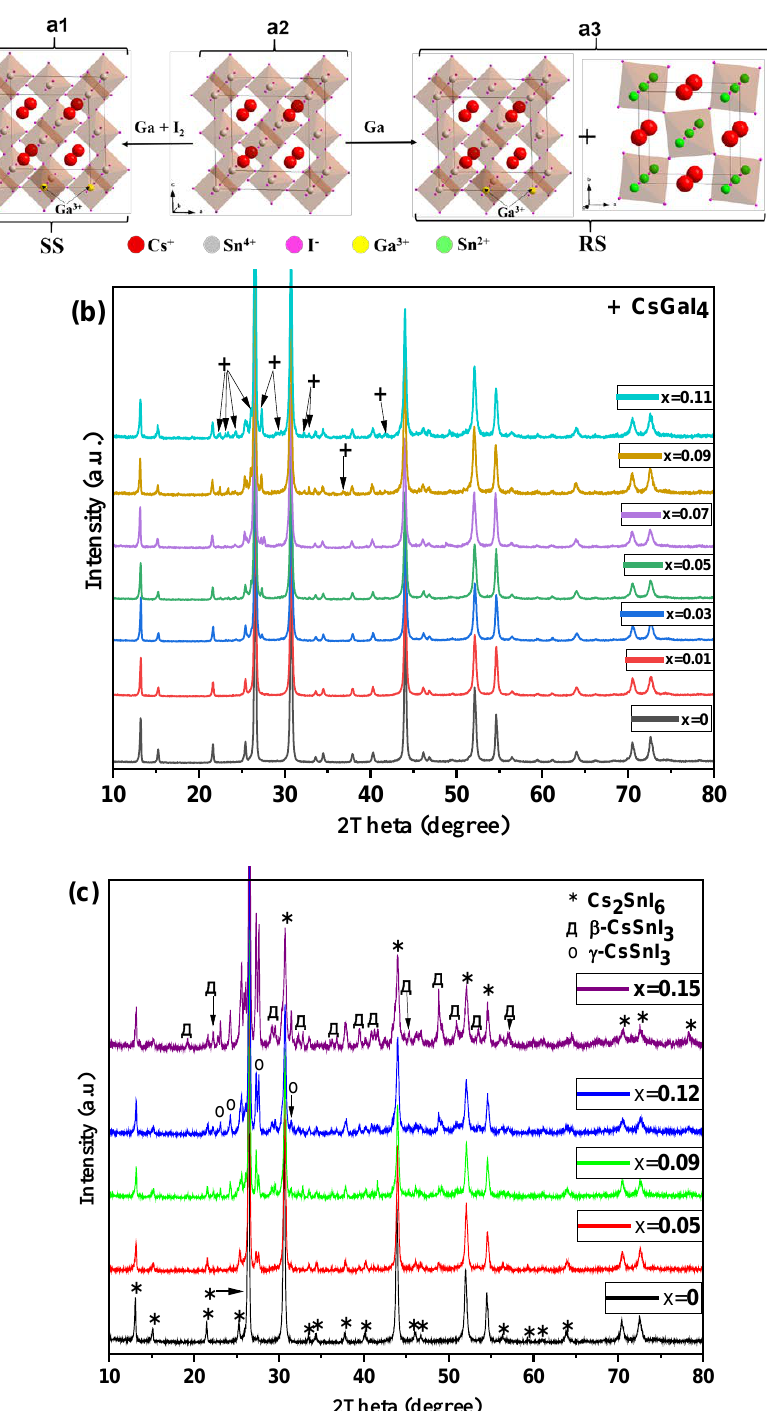
Figure 1. ( a1 ) Possible positions of heteroatoms (Ga 3+ ) in Cs 2 SnI 6 perovskite lattice; ( a2 ) Cs 2 SnI 6 unit cell; ( a3 ) Cs 2 SnI 6 reduction result. XRD data for ( b ) Cs 2 SnI 6 -based solid solutions and ( c ) the samples obtained by reduction with the melt of metallic gallium (x = 0–0.15). In diffractograms of SS samples, impurity-phase CsGaI 4 —reflections are marked with + symbols—and all unmarked reflections belong to Cs 2 SnI 6 . In diffractograms of RS series, β -CsSnI 3 peaks are marked with ⊗ -symbols, γ -CsSnI 3 peaks are marked with ο -symbols, and Cs 2 SnI 6 peaks with the symbol *. According to Figure 1b, the XRD patterns of two samples related to the SS series (namely, x = 0.01 and 0.03) and one related to the pristine Cs 2 SnI 6 (where x = 0) can be regarded as single phase. Contrastingly, the XRD patterns of the RS series (Figure 1c) distinctly show the presence of the β -CsSnI 3 secondary phase. The most intensive dif- fraction peaks are associated with reflections of Cs 2 SnI 6 (PDF2 file #73-330), while the weaker group of peaks is associated with reflections of γ -CsSnI 3 (PDF2 file #71-1898). The intensities and number of CsSnI 3 -characteristic reflections increase with the percentage of gallium in the samples before the heat treatment (0 → 0.15). Meanwhile, diffractograms do not show reflections of any iodogallates such as CsGaI 4 and CsGa 2 I 7 (Figure 1c). It is remarkable that for the samples with the substitution rate x of 0.09–0.15, the presence of B- β -CsSnI 3 (PDF2 file #80- 2138) was observed. This β -phase is stable ther- modynamically at higher temperatures of 78–152 °C but is present in the RS samples to- gether with low-temperature B- γ -CsSnI 3 . Table 1 shows the unit-cell parameters for the perovskite-related phase of Cs 2 SnI 6 , which were determined using the Le Bail method. The estimated unit-cell parameter a for the undoped Cs 2 SnI 6 perovskite phase was found to be 11.6416 (8) Å, which is close to recently reported data (11.630 (10) Å, according to the PDF2 file 73-330). The evolution of the unit-cell parameter with increasing dopant content for the SS samples demonstrated a slight increase of the cell parameter a to 11.6426 (5) Å ( x = 0.05). The unit-cell volume V changes only slightly. It changes the same way with an increase of gallium percentage in the charge (Table 1). It is important that the radius of Ga 3+ is smaller than that of Sn 4+ (0.62